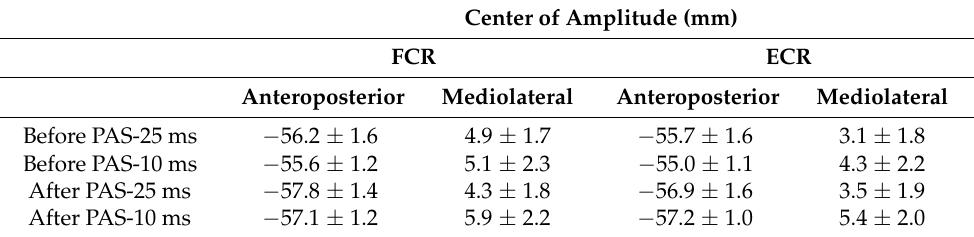
Table 1. Center of amplitude of peak-to-peak MEP amplitudes before and after